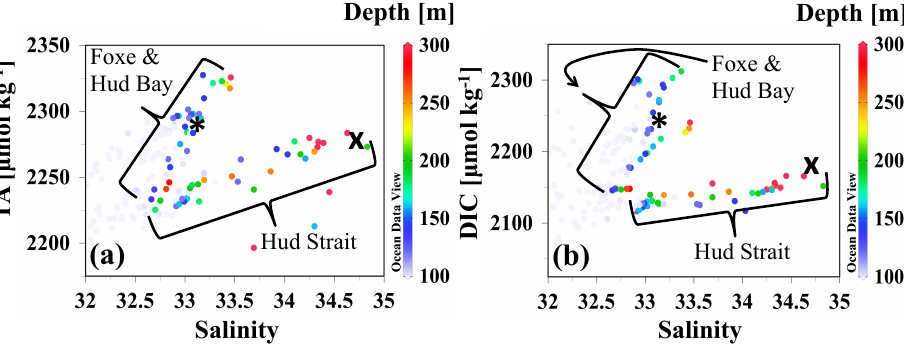
Figure 3. Deep (>100m) water TA (a) and DIC (b) against salinity throughout the Hudson Bay system. The * represents the end-member properties of Pacific-origin Upper Halocline Water ( S = 33.1, TA = 2283µmolkg − 1 , DIC = 2236µmolkg − 1 ) and the black “x” represents Atlantic Water ( S = 34.8, TA = 2301µmolkg − 1 , DIC = 2154µmolkg − 1 ) , as defined by Shadwick et al. (2011). Hud Bay: Hudson Bay samples; Foxe: Foxe Strait samples; Hud Strait: Hudson Strait